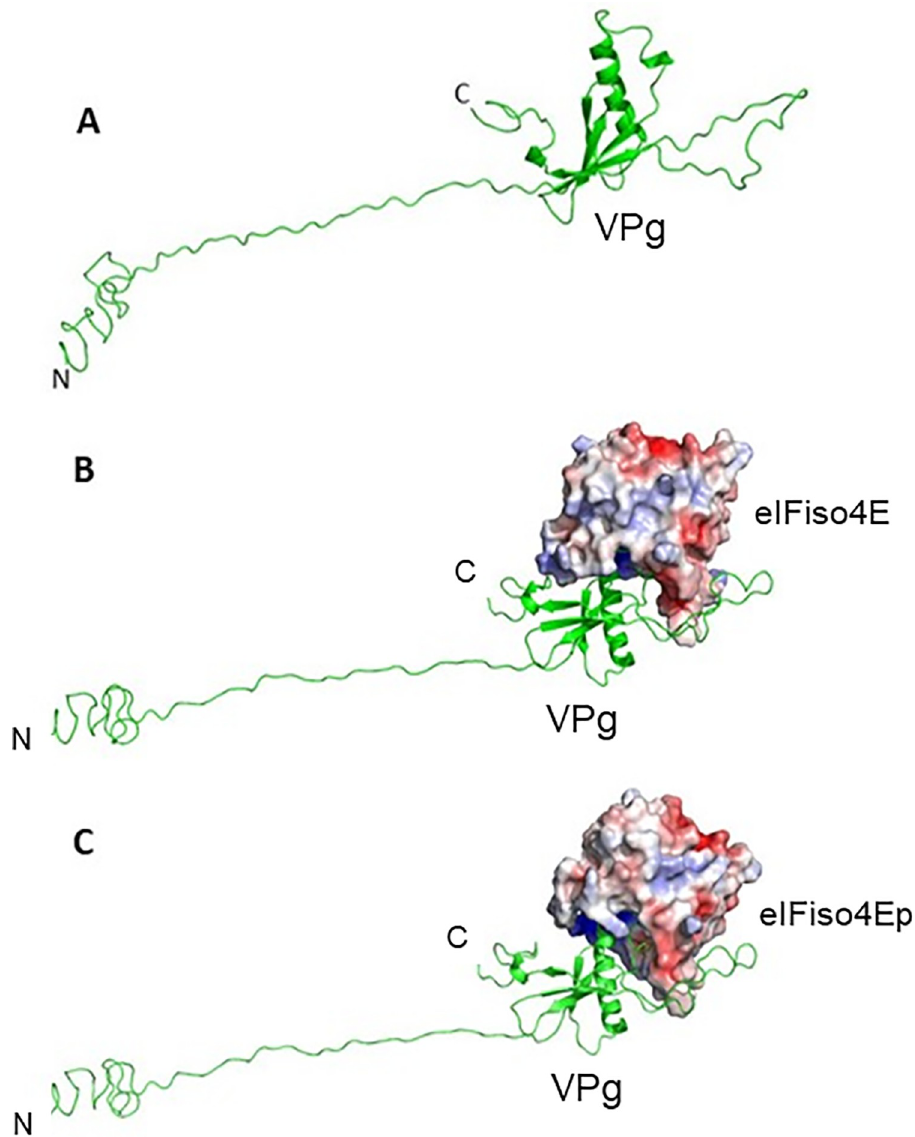
Fig 7. Molecular modeling of VPg and docking interactions with phosphorylated eIFiso4E. (A) Homology model of full-length turnip mosaic virus VPg shown in pale green cartoon representation. (B) Docking of VPg model (pale green cartoon) with eIFiso4E. (C) Docking of VPg model (pale green cartoon) with eIFiso4Ep. eIFiso4E and eIFiso4Ep are represented as surface electrostatic diagram. unstructured. Like potyvirus VPg structure, only residues 73–178 of turnip mosaic virus VPg were generated ordered secondary structure components in the model. The structural part consisted of six beta-strands and one alpha-helix. The strand four and five were connected to a big loop (Fig 7A). Molecular docking models confirmed the binding of VPg with the eIFiso4E and eIFiso4Ep. In both the cases, the acidic residues of the VPg were observed to bind with a basic patch of the eIFiso4Ep (Fig 7B and 7C). Attachment of monophosphate at the serine 209 position of eIFiso4E did not induce any structural changes, except a subtle change in the loop region at the phosphorylation site was observed when compared with un-phosphorylated